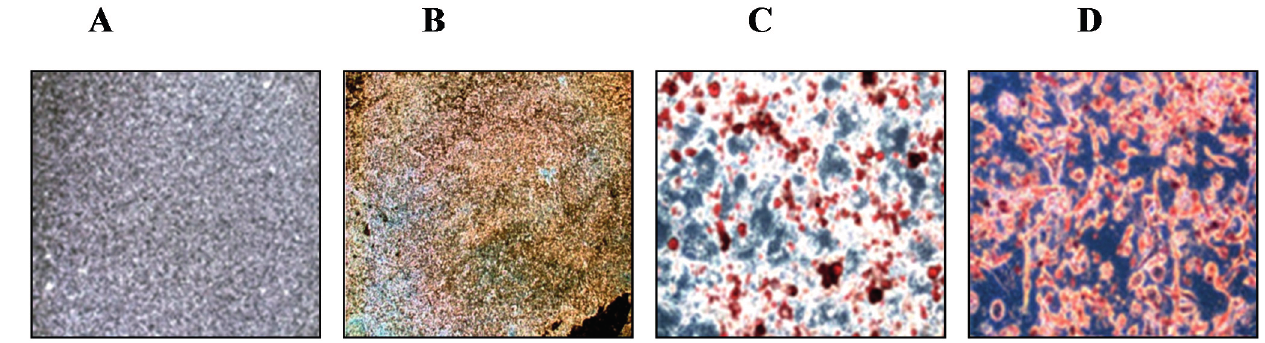
Figure 1. Histological analysis of mesenchymal stem cells from rabbit subchondral bone undergoing chondrogenic, adipogenic, and osteogenic differentiation. ( A ) control; ( B ) chondrogenic differentiation visualized by staining with alcian blue; ( C ) adipogenic differentiation visualized by staining with Oil Red O; and ( D ) osteogenic differentiation visualized by staining with Alizarin